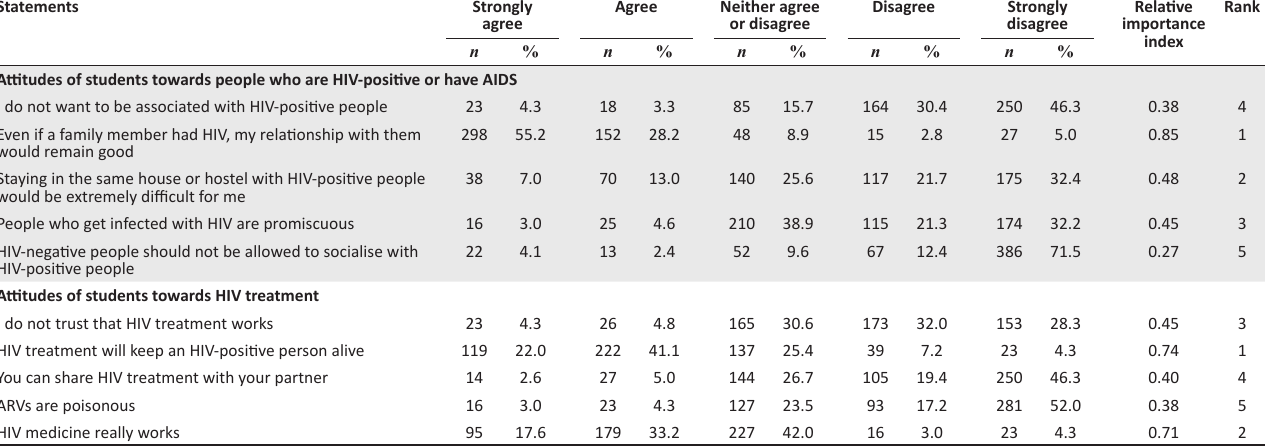
TABLE 5: Attitudes of students towards people who are HIV-positive or have AIDS and HIV and/or AIDS treatment. Statements Strongly agree